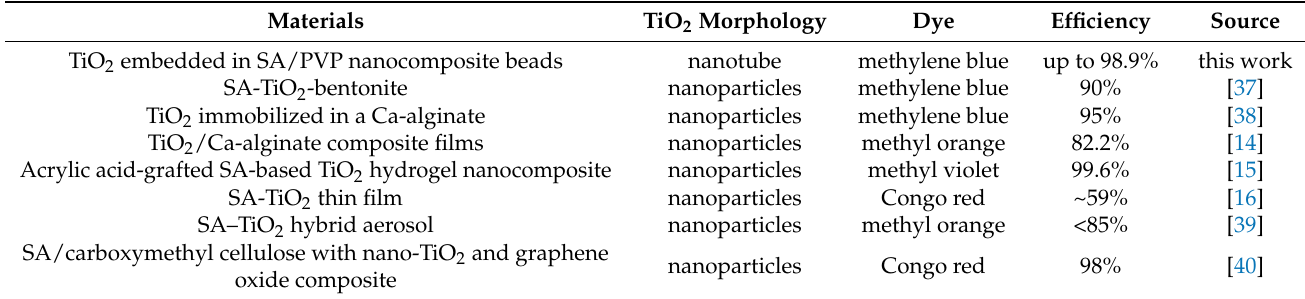
Table 3. Photodegradation behavior towards organic dyes of different TiO 2 -based composites.